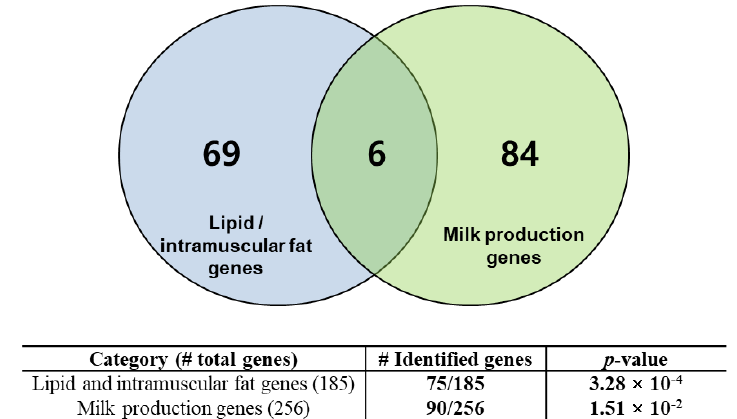
Figure 3. Functional genes identified based on conditional mutual information. The identified genes were enriched in lipid / intramuscular fat genes or mammary gland / milk production-related genes with significant p -value levels.